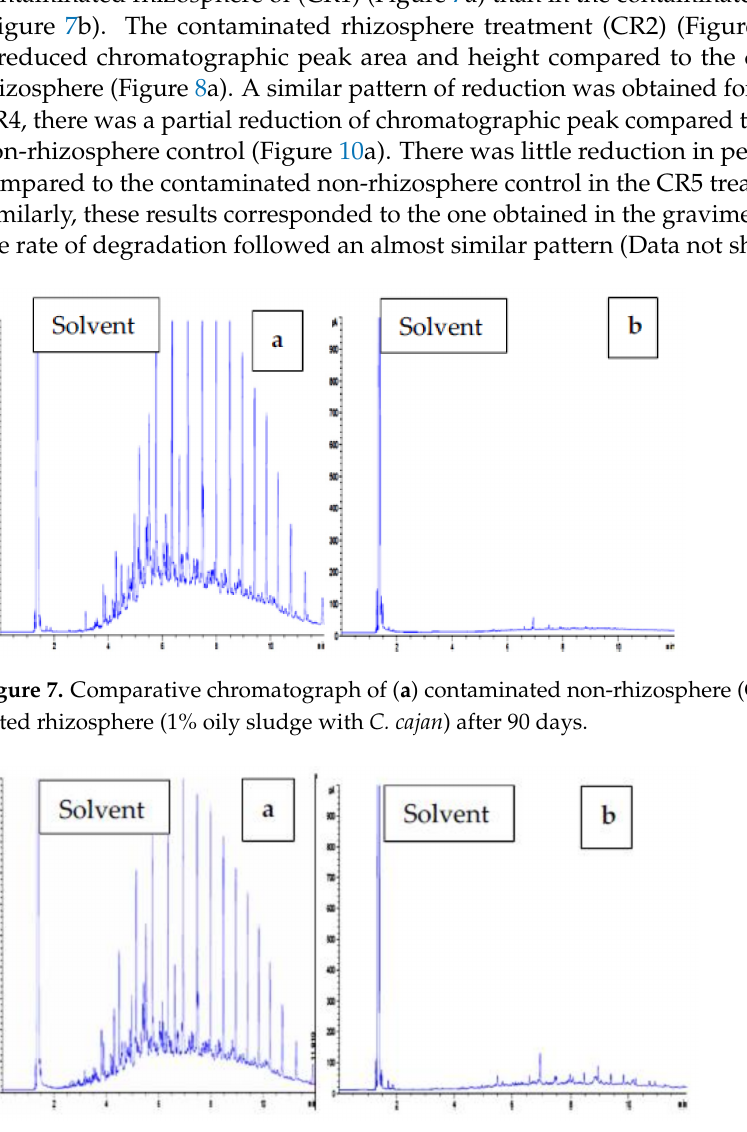
Figure 8. Comparative chromatograph of ( a ) contaminated non-rhizosphere (CN) and ( b ) contami- nated rhizosphere (2% oily sludge with C. cajan ) after 90